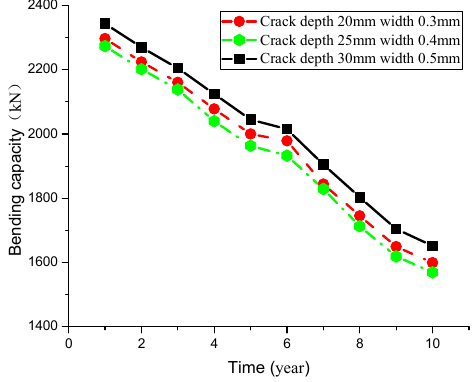
Figure 10. Variation trend of flexural bearing capacity over time.